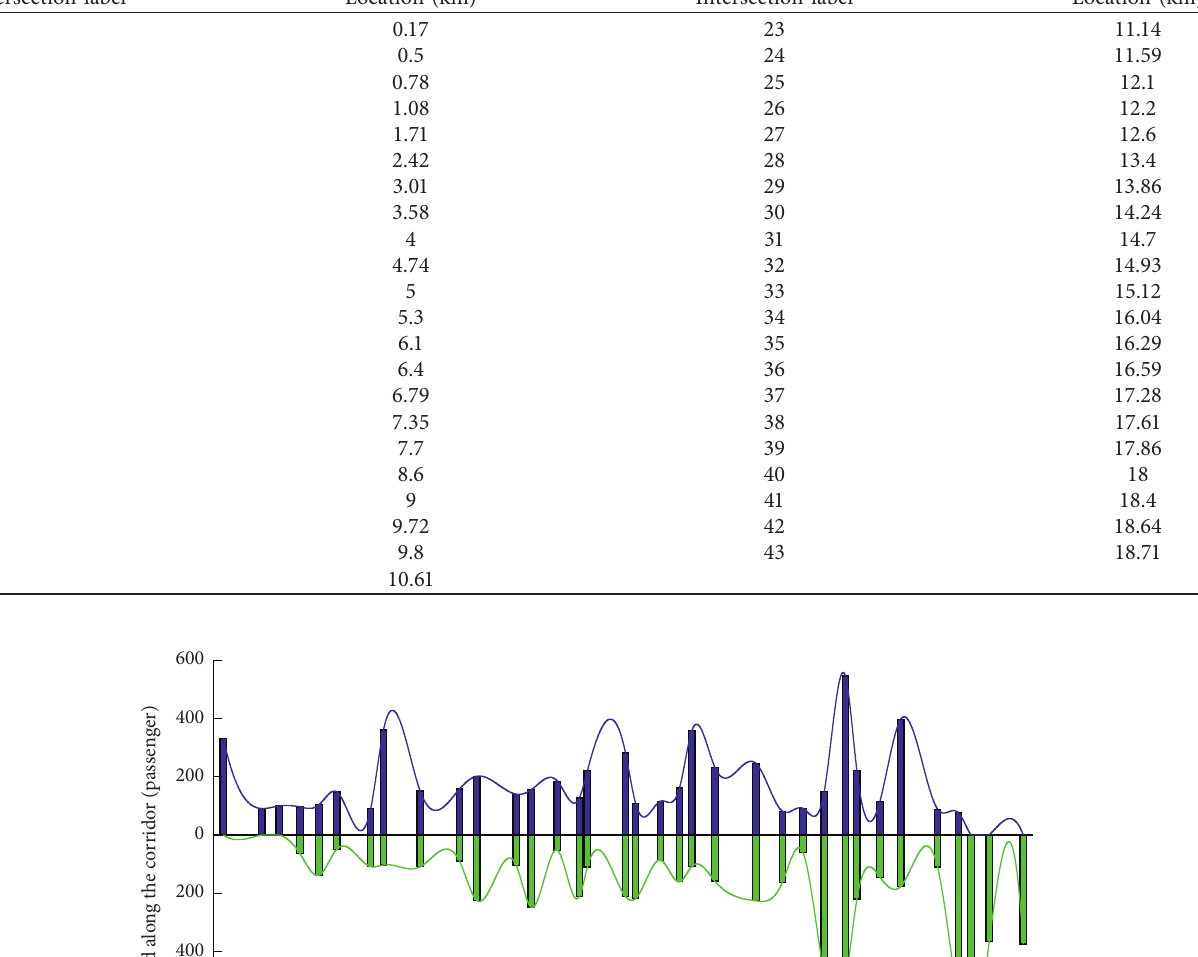
Table 4: Intersections along bus route no. 3.